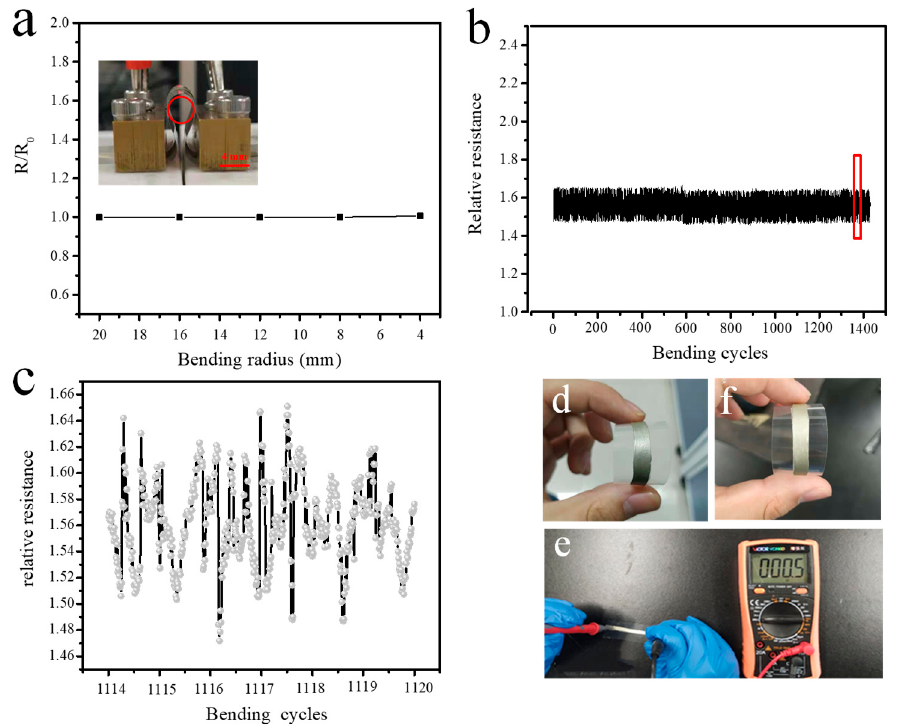
Figure 7. The electrical resistivity of PC-ECAs’s patterns (PC-1) as a functional of rolling radius ( a ), the cyclic performance of PC-ECAs s patterns ( b ), the resistance change of the patterns on the 114–1120 bend-release cycles ( c ), the patterns before 1500 bending cycles ( d ), the patterns after 1500 bending cycles ( f ), and the electrical resistance of the patterns after 1500 bending cycles ( e ).